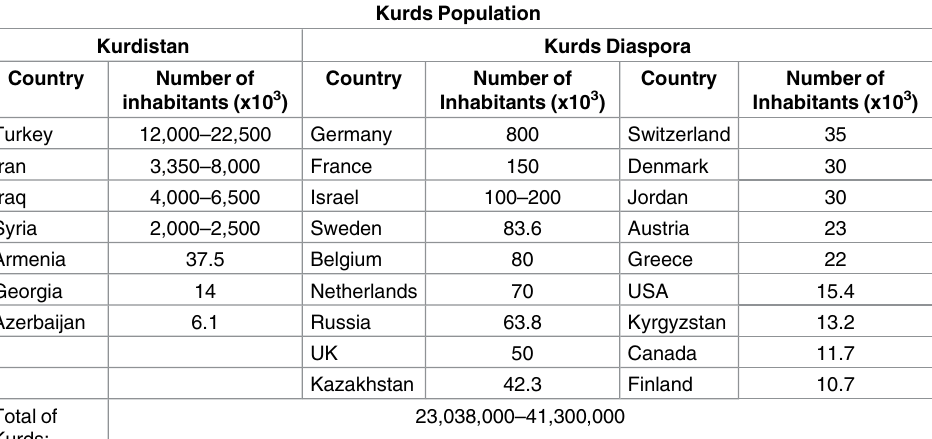
Table 1. Kurds population around the World